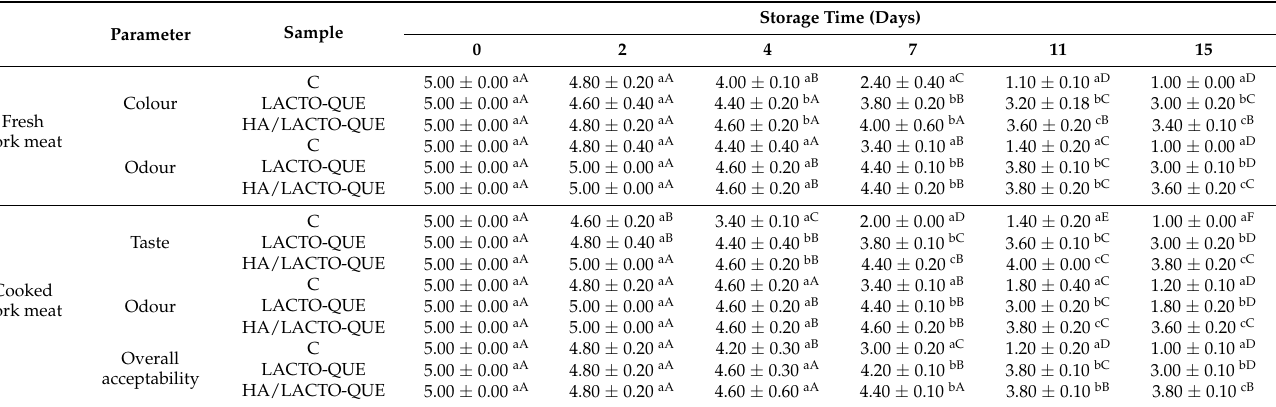
Table 4. Effects of alginate-based coatings on sensory parameters of pork meat samples during the cold